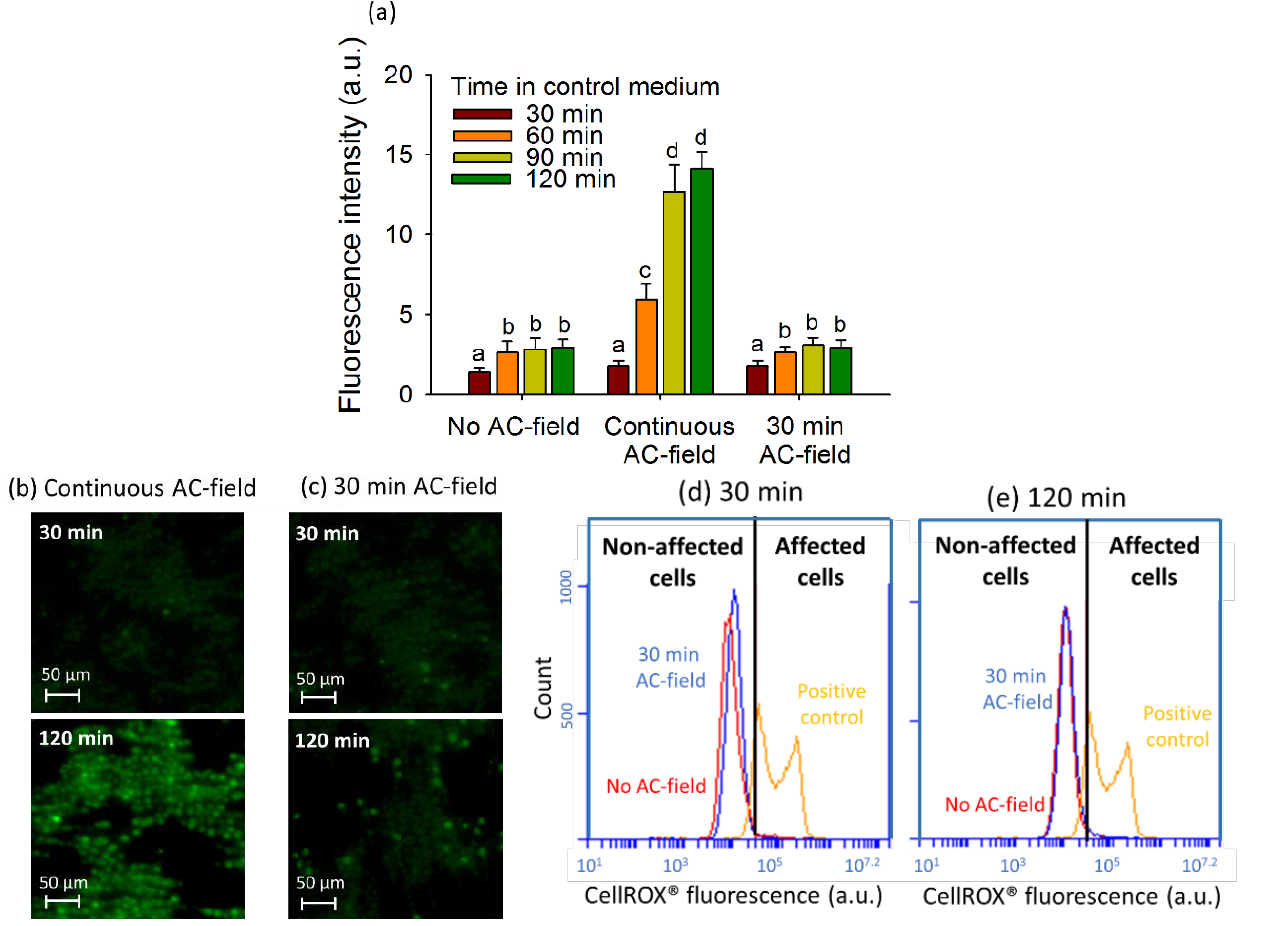
Figure 4. Effect of the AC-field duration on fluorescence intensity of 2D cell assemblies. ( a ) Fluorescence intensity corresponding to the mean corrected CellROX ® fluorescent intensity per pixel calculated from the fluorescent images obtained in FITC channel for different modes of the AC-field application. Different letters (from ( a ) to ( d )) indicate the existence or not of the statistically significant difference and were obtained by Student-Newman-Keuls test with p < 0.05; Microscopy images of CellROX ® stained 2D-assembly with continuous AC-field ( b ) and AC-field applied for 30 min ( c ); FCM cytograms for CellROX ® Green stained cells with no AC-field and AC-field applied for 30 min for exposure in the control medium for 30 min ( d ) and 120 min ( e ). The initial concentration of algae in suspensions was 5 × 10 6 cells·mL −1